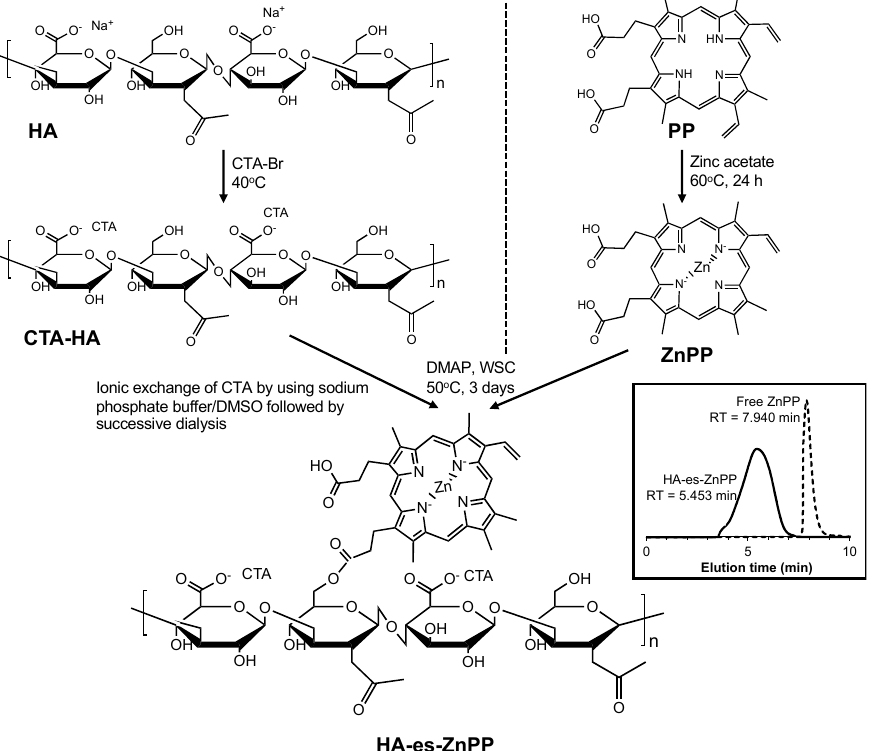
Figure 1. Synthesizing protocol of hyaluronan (HA) conjugated ZnPP through ester bond (HA-es-ZnPP). Inset shows the gel permeation chromatograph of HA-es-ZnPP and free ZnPP, by using a high-performance liquid chromatography (HPLC) system with an Asahipak GF-310 HQ column.